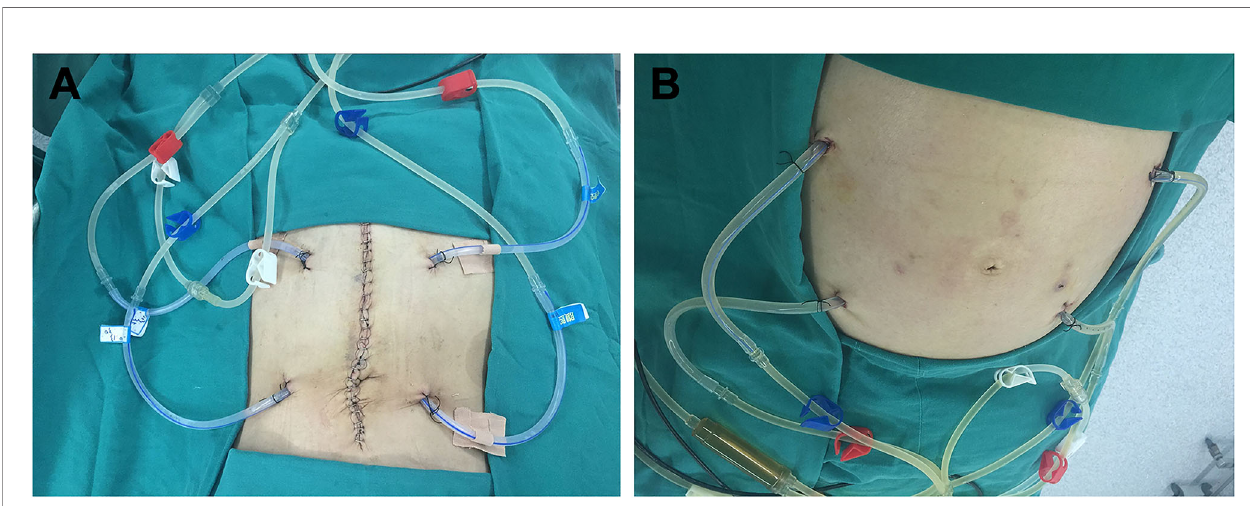
FIGURE 3 | Placement sites of the infusion and out fl ow catheters for HIPEC followed by dCRS. (A) Localization of the infusion and out fl ow catheters for HIPEC followed by dCRS. (B) Localization of the infusion and out fl ow catheters for HIPEC followed by minimally invasive surgery. The red clips mark the two infusion catheters. The blue clips mark the two out fl ow catheters. The white clips mark the loop circuit for HIPEC